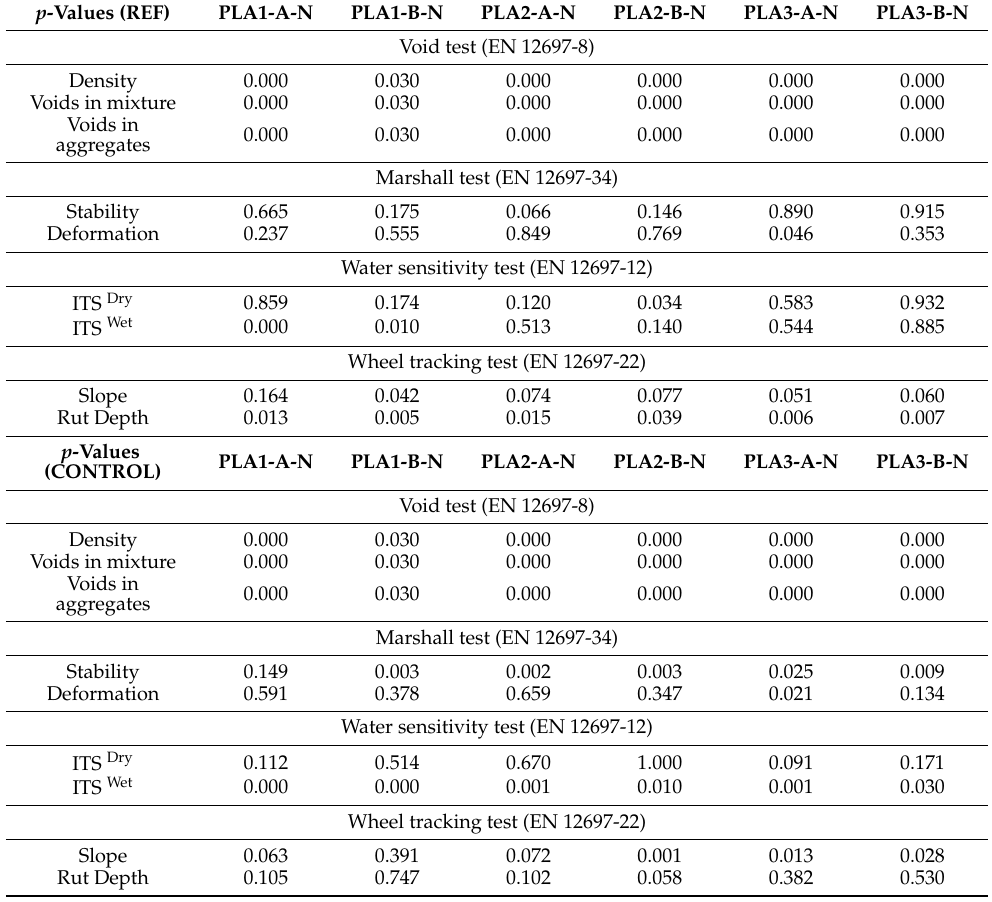
Table 5. p -values from experimental tests. Reference and control